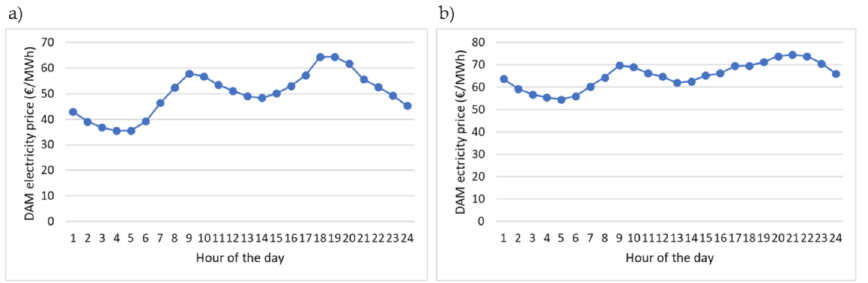
Figure 16. Average hourly prices of electricity on the national energy market for the: ( a ) representative winter day; ( b ) representative summer day.